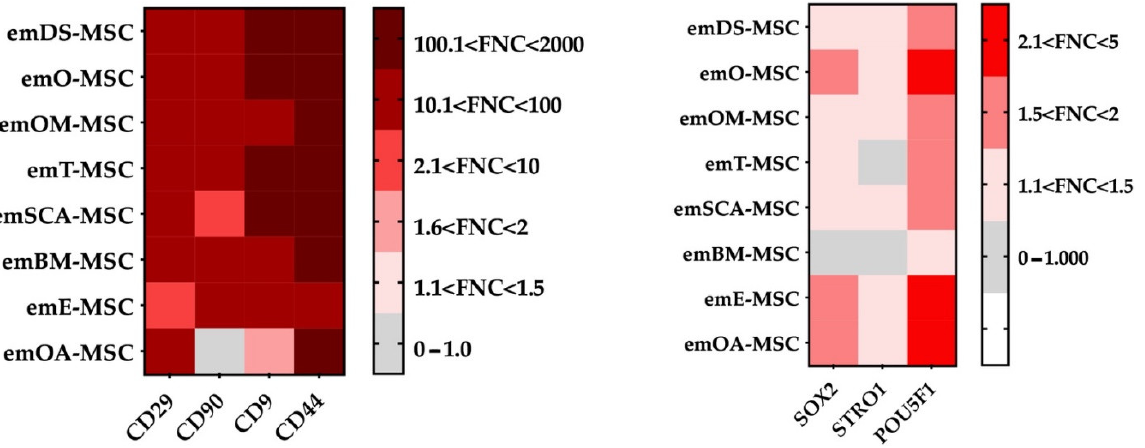
Figure 3. Analysis by flow cytometry of the expression levels of cell surface markers CD29, CD90, CD9, CD44, SOX2, STRO1, and POU5F1 in emDS-MSC, emO-MSC, emOM-MSC, emT-MSC, emSCA- MSC, and emBM-MSC, emE-MSC, and emOA-MSC. Heat map showing the mean fluorescence intensity (folds of negative control (FNC) in the absence of primary antibody) for each